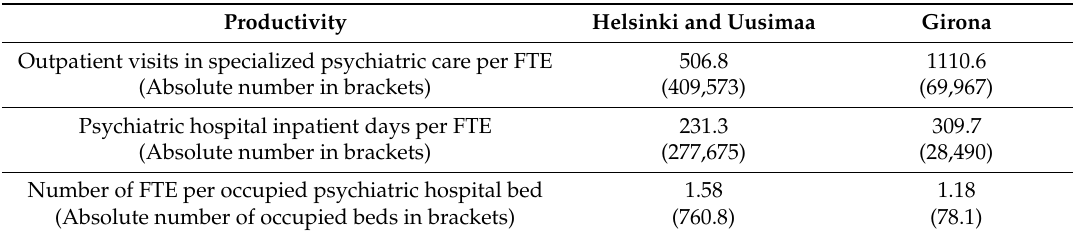
Table 4. The productivity of specialized psychiatric care expressed as the number of outpatient visits and hospital inpatient days per FTE and the number of FTE per occupied psychiatric hospital bed. Productivity Helsinki and Uusimaa